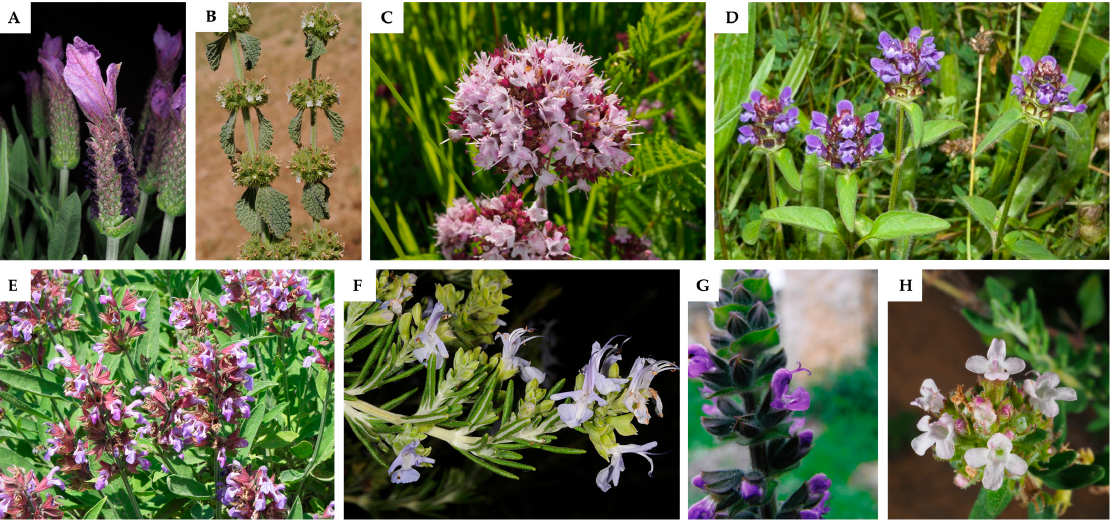
Figure 1. Lamiaceae species with scientific evidence for their wound healing use in the Iberian Peninsula. Images of the plants ( A )— Lavandula stoechas L., ( B )— Marrubium vulgare L., ( C )— Origanum vulgare L., ( D )— Prunella vulgaris L., ( E )— Salvia officinalis L., ( F )— Salvia rosmarinus Schleid (Syn: Rosmarinus officinalis L.), ( G )— Salvia verbenaca L. and ( H )— Thymus vulgaris L. were obtained from the website Plants of the World Online (http://www.plantsoftheworldonline.org/ accessed on 4 February 2023).